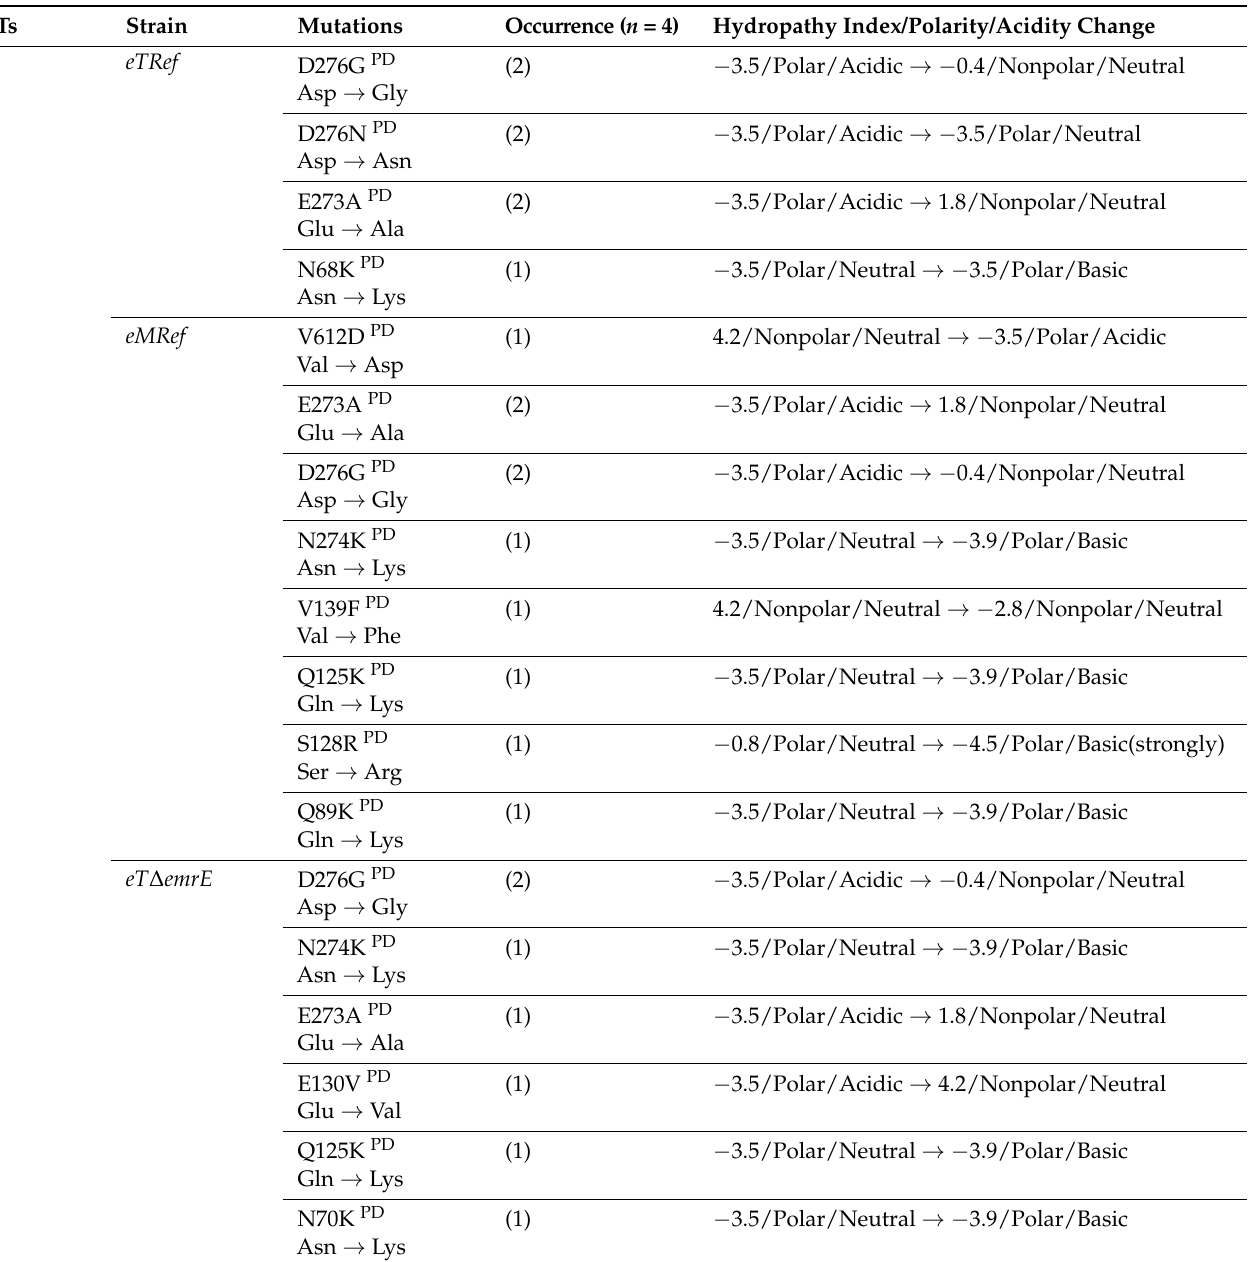
Table 2. Structural mutations targeted unique ORFs identified for potential multidrug transporters (MDTs). Depicted are the amino acid substitutions in MDTs reported for multiple strains evolved in both experimental conditions. Hydropathy indices are reported from